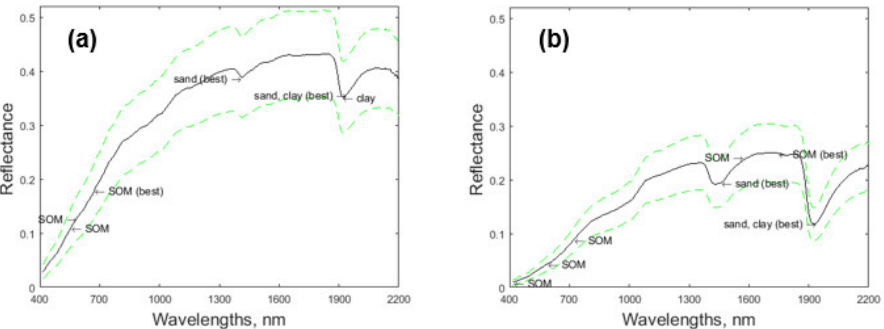
Figure 10. The identified regions from the vis–NIR soil spectra capable of exhibiting the highest possible degree in terms of the precision and accuracy component, when predicting % sand, % clay, and SOM in ex situ ( a ) and in situ ( b ) measurement